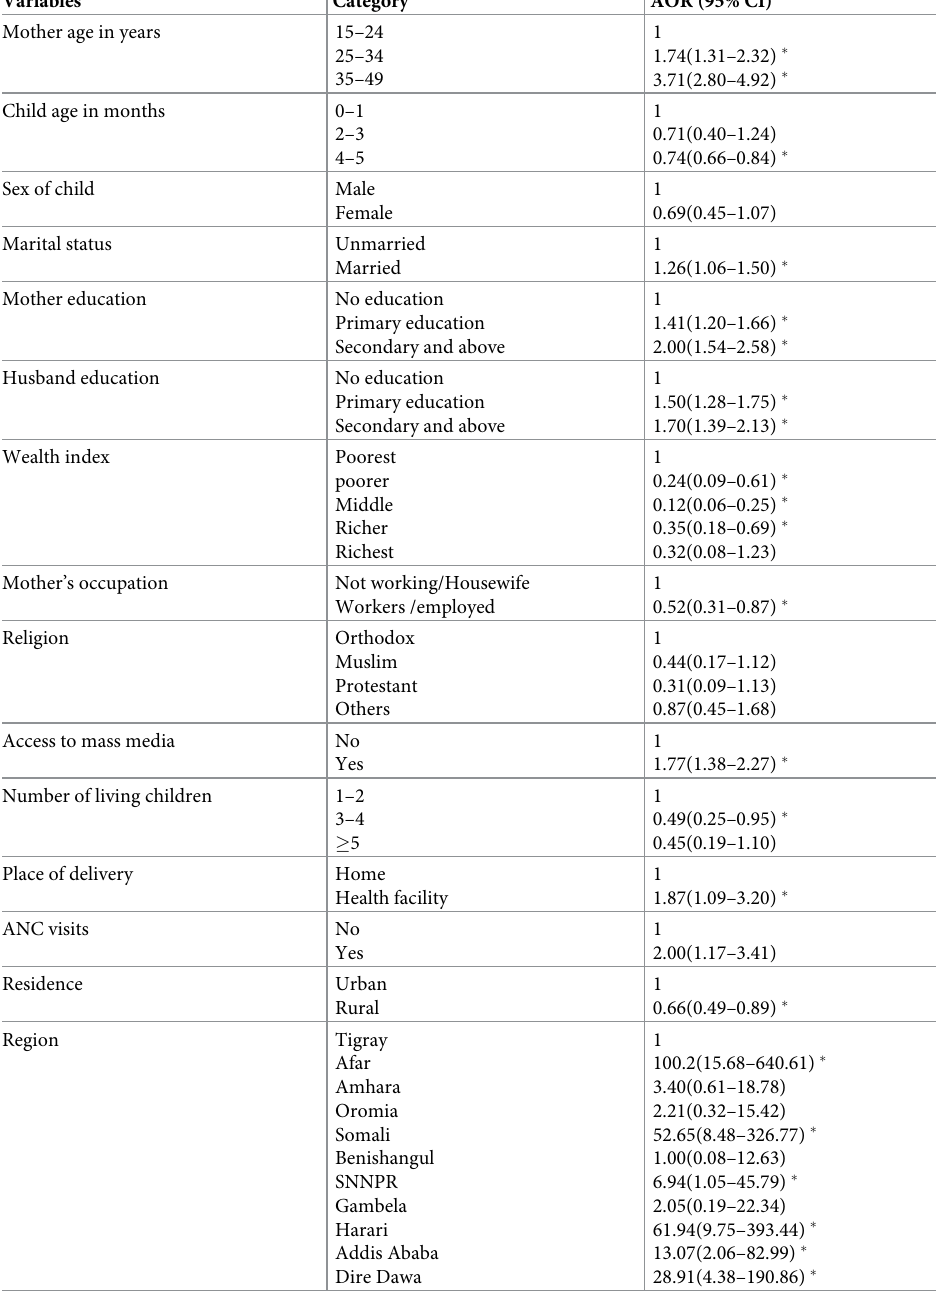
Table 2. Factors associated with EBF practice among mothers in Ethiopia, EDHS